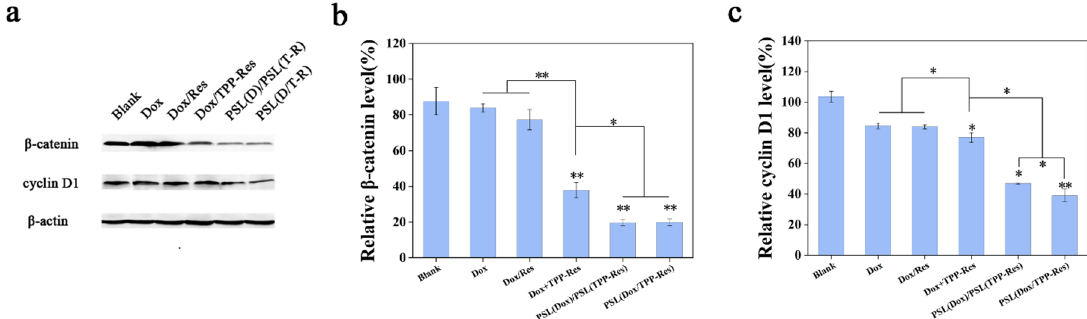
Figure 8. ( a ) Western blotting analysis of β -catenin and cyclin D1 in CSLCs treated with different formulations. ( b ) β -catenin and ( c ) cyclin D1 relative to β -actin were determined by Image J. Data were expressed as mean ± SD (n = 3), * P < 0.05, ** P < 0.01 compared with the blank group.